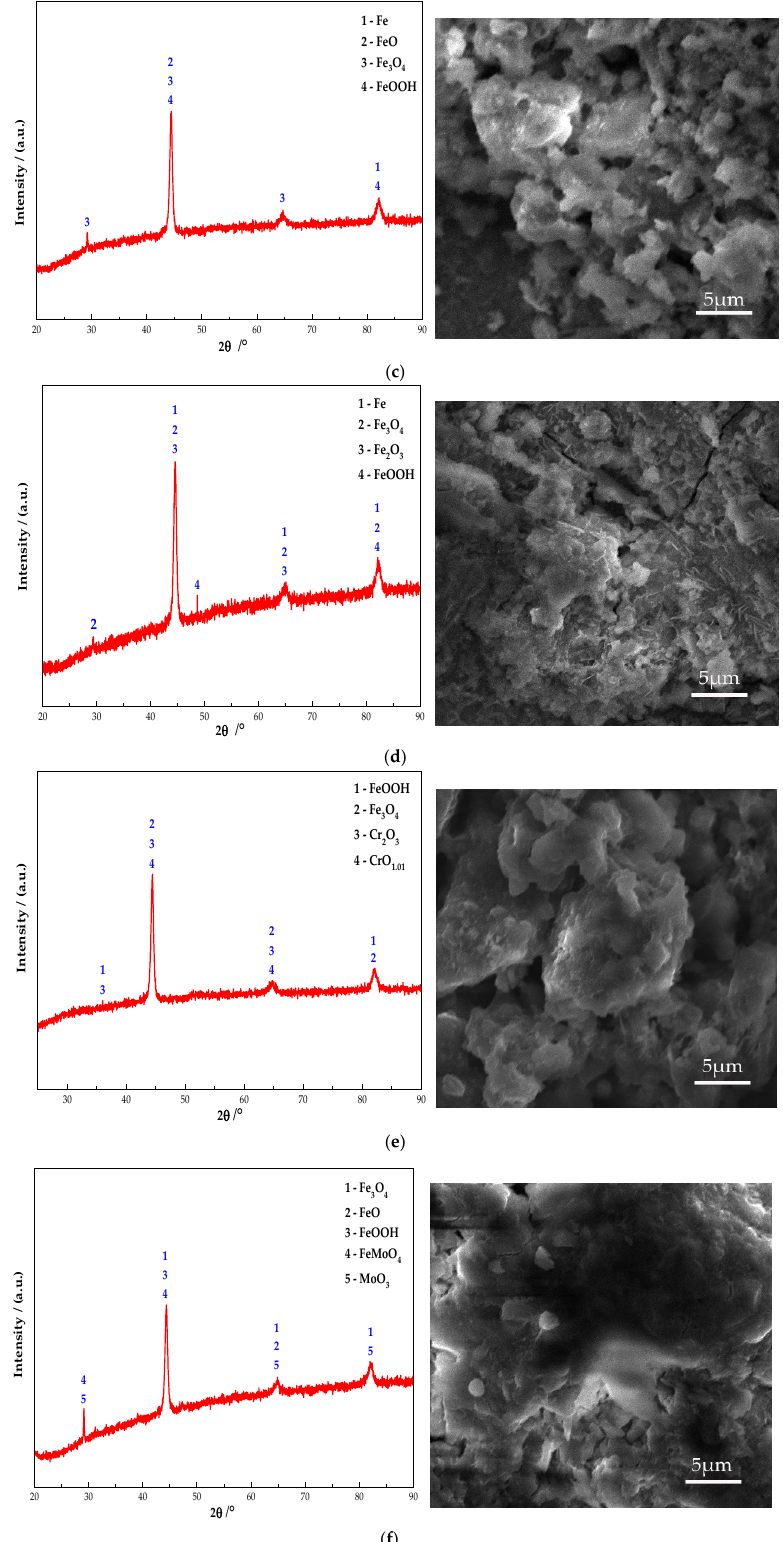
Figure 10. XRD patterns and micromorphology of the passive film on the steel sample surface under the action of different rust inhibitors. ( a ) Na 2 CrO 4 group. ( b ) Na 2 MoO 4 group. ( c ) BTA group. ( d ) DMEA group. ( e ) Na 2 CrO 4 + BTA group. ( f ) Na 2 MoO 4 + BTA